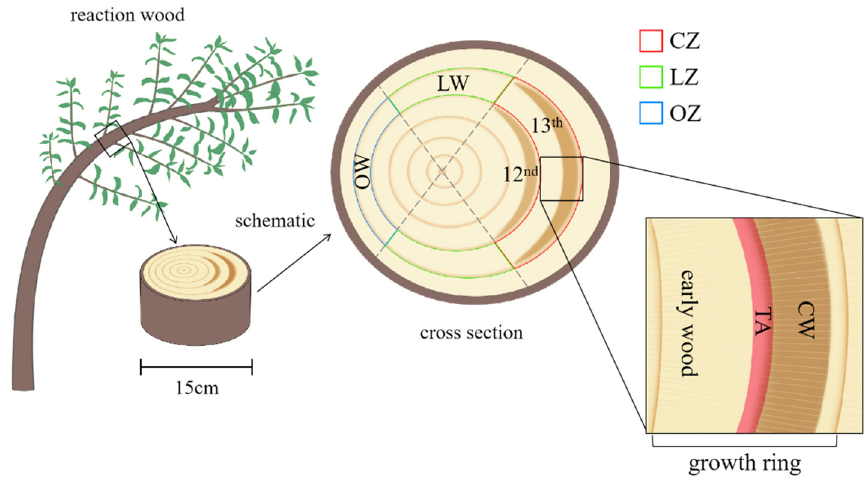
Figure 1. Reaction wood sample illustration. Compression zone (CZ), lateral zone (LZ), and opposite zone (OZ) in an individual growth ring of Taxodium hybrid Zhongshanshan. Compression wood (CW) and transition area (TA) are in the CZ. The wood in OZ is called opposite wood (OW), and the wood in LZ is called lateral wood (LW).